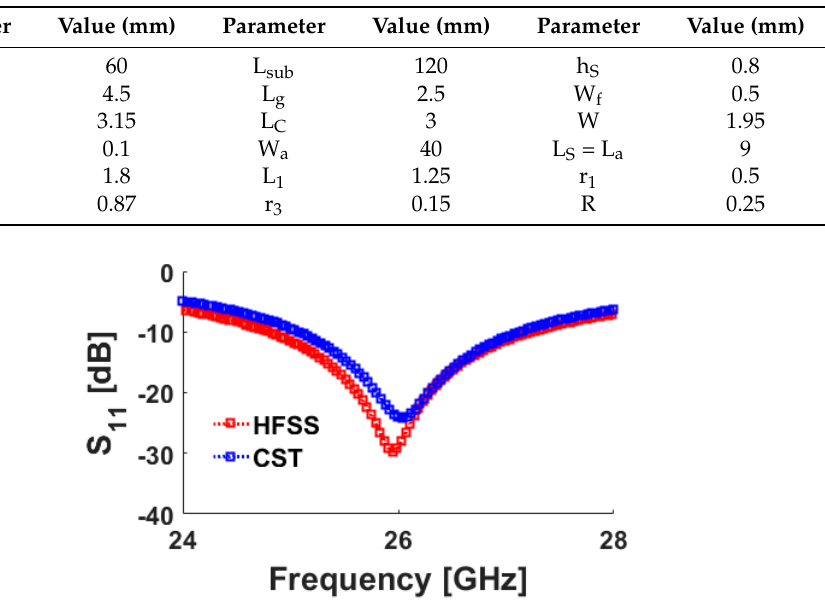
Table 1. Parameter values of the Quasi-Yagi antenna and its array design.